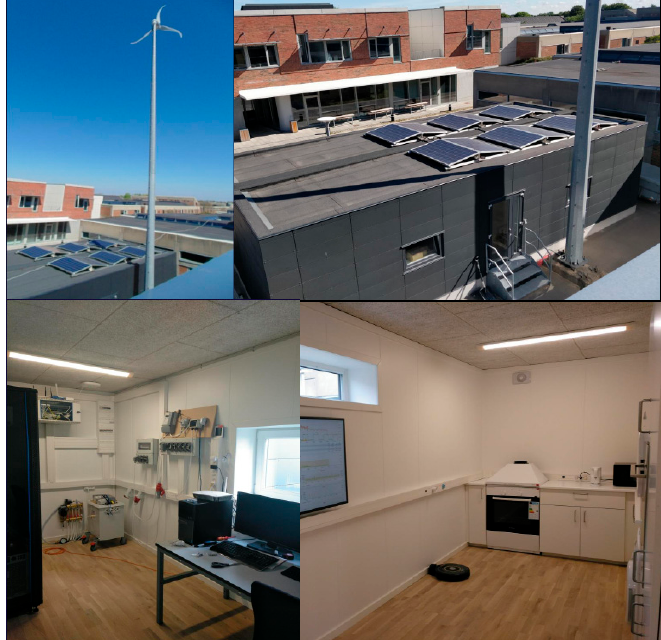
Figure 7. Photographs of IoT-MGLab at Aalborg University.